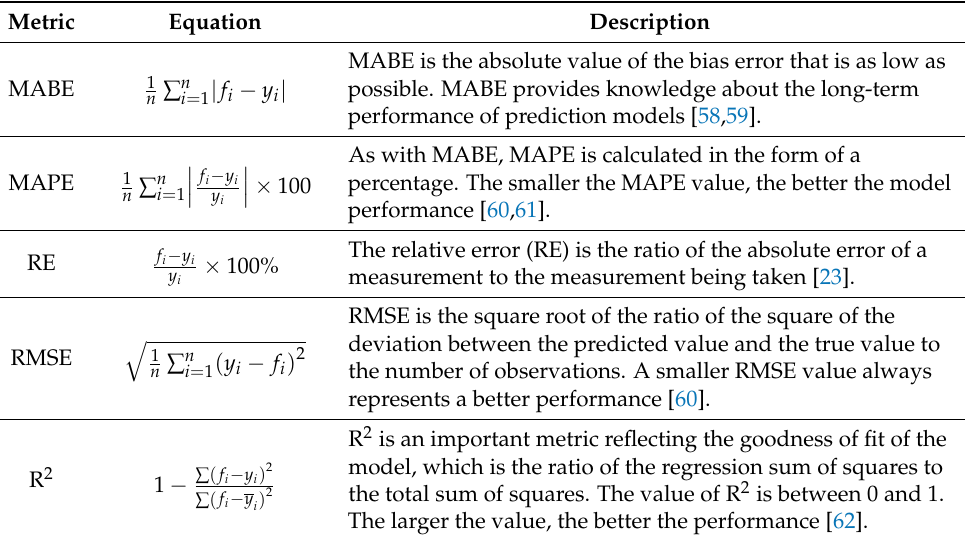
Table 3. Descriptions of error metrics used to evaluate the prediction accuracy of machine learn- ing